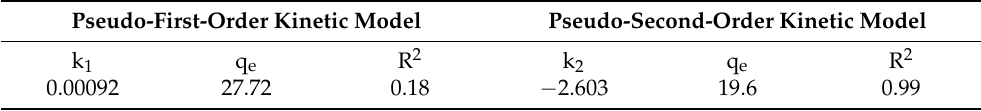
Table 3. The kinetic parameter for the adsorption of BG dye on F. benghalensis leaves powder. Pseudo-First-Order Kinetic